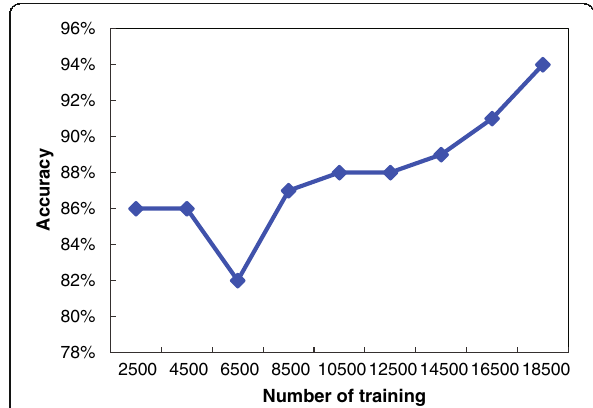
Fig. 8 Model recognition results obtained by different iteration training times. By training the generated data with different effects, the discriminatory ability of the model is different. Therefore, this experiment verifies the impact on the model by using the generated data of different iteration training